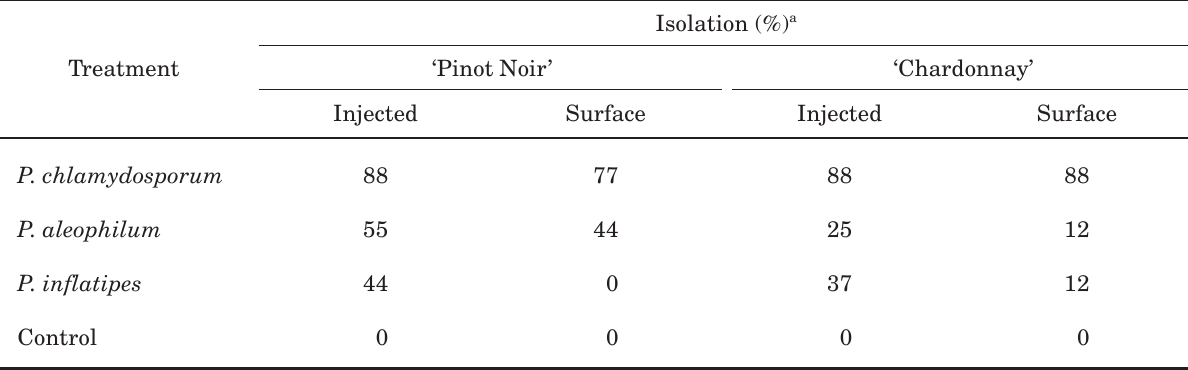
Table 6. Percent isolation of Phaeoacremonium chlamydosporum, P. aleophilum and P. inflatipes from inoculated spurs of standing vines cv. Chardonnay and Pinot Noir. Pathogens were either injected into the pith or applied as a drop of spore suspension to the cut surface of grapevine